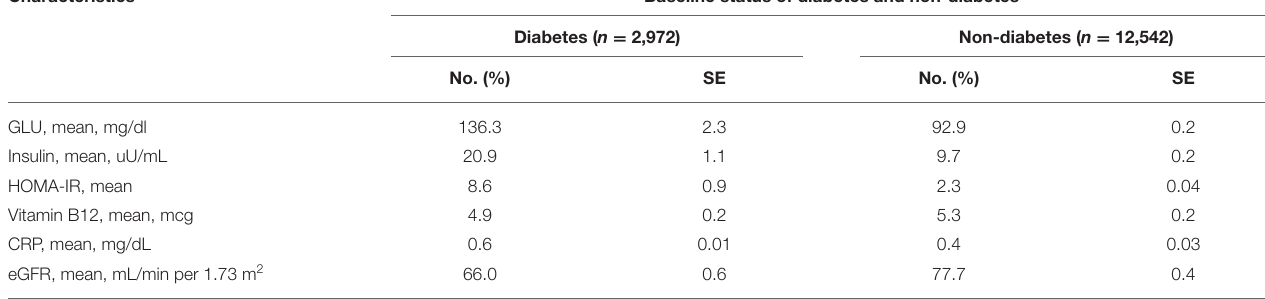
Characteristics Baseline status of diabetes and non-diabetes